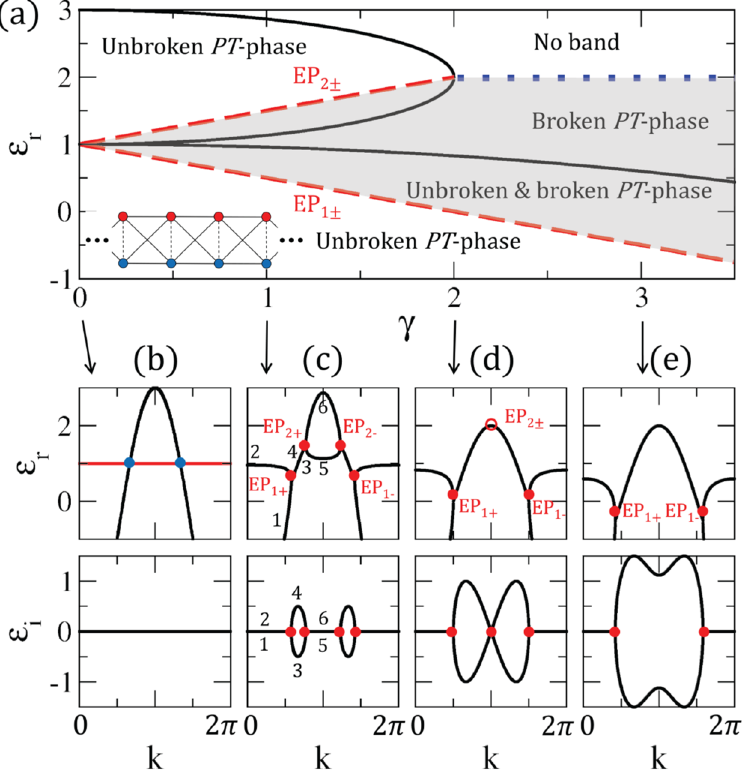
Figure 1. ( a ) Phase diagram of PT -symmetric CS lattice. Black curves represent the band edges of unbroken PT -symmetric phase ε * . There are two red dashed lines of EPs inside the unbroken PT -symmetric phase regions: EP 1 ± and EP 2 ± . The shaded region indicates the broken PT -symmetric phase, which includes a coexistent region with unbroken and broken phases. The blue dotted line is the critical energy ε c = 2 d . (inset) PT -symmetric CS lattice with coupling strengths t (dashed lines) and d (solid lines). The complex energies on the upper sites (red dots) and lower sites (blue dots) correspond to energy gain + i γ /2 and energy loss − i γ /2, respectively. ( b ) Complex energy band for the CS lattice. The constant energy band assigned by the solid red line is the flat band, and the blue dots represent accidental degenerate points. ( c – e ) Complex energy bands with different non-Hermitian imbalanced potentials. The red dots are exceptional points. We fix t = d = 1 throughout this